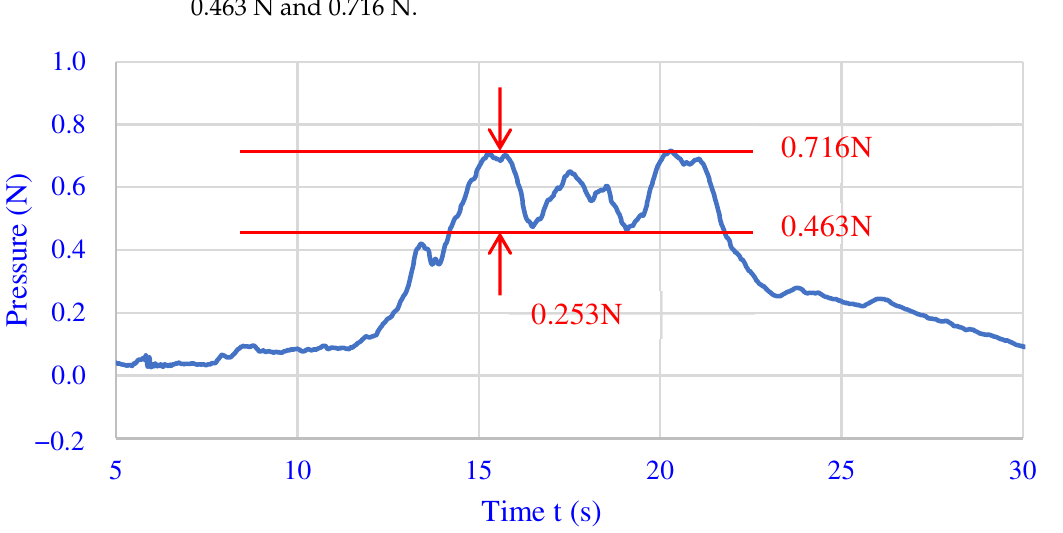
Figure 8. Schematic diagram of pressure measuring device structure.